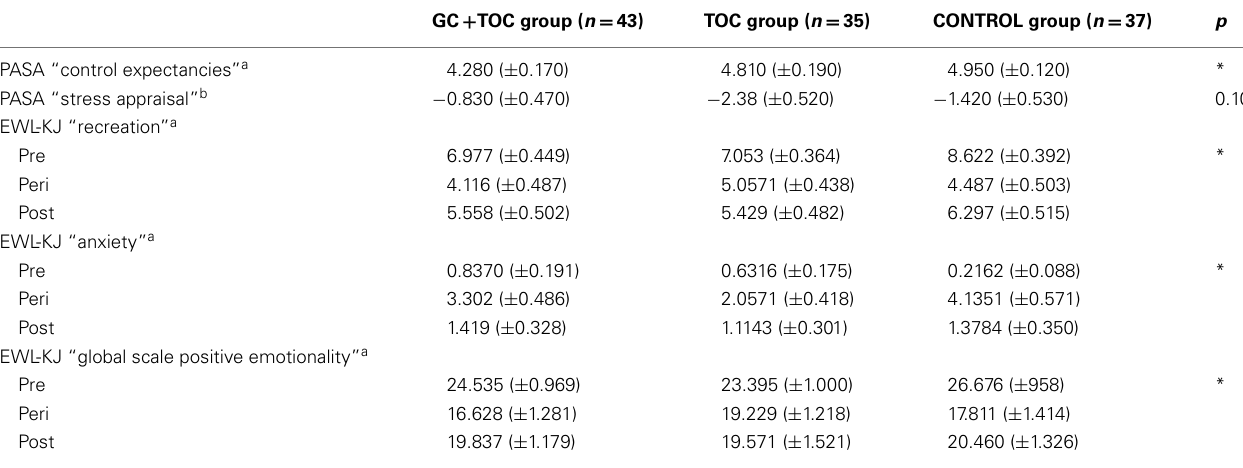
Table 2 |Anticipatory stress appraisal (PASA) before theTSST-C and mood of children (EWL-KJ) at baseline, during and after theTSST-C in children with glucocorticoid (GC) and tocolytic (TOC) administration ( n = 43), children of theTOC group ( n = 35), and children of the CONTROL group ( n = 37; means ±